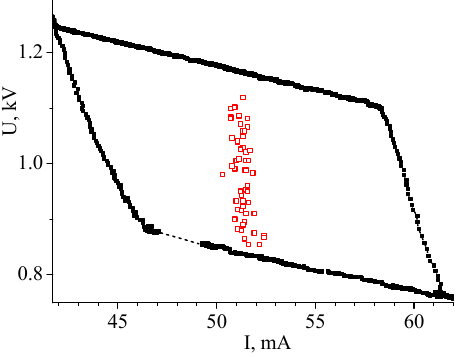
Figure 14. Manifold of PCD points (open squares) for the discharge in the Ar + 0.02%N 2 mixture at P = 50 Torr [16]. (© IOP Publishing. Reproduced with permission. All rights reserved.)